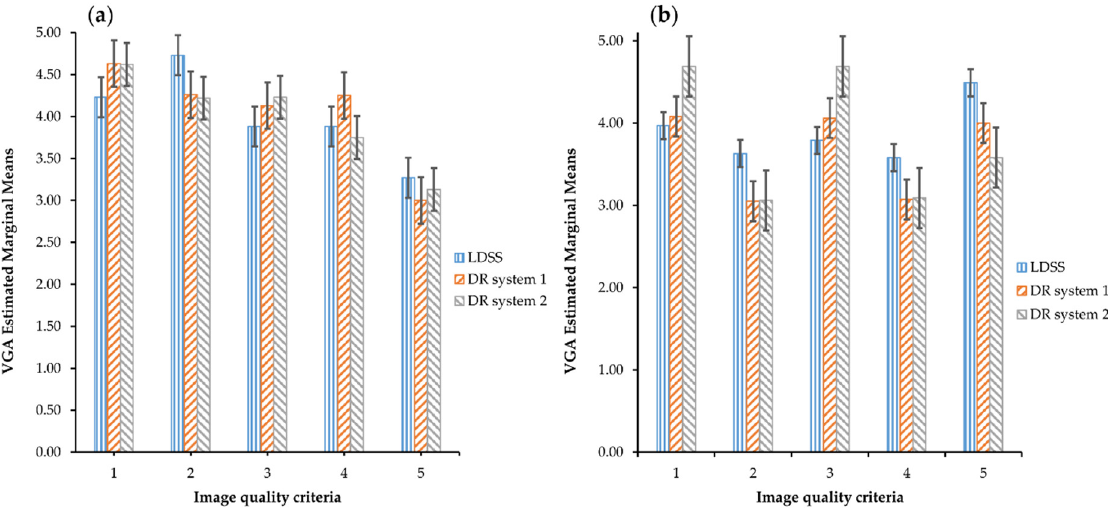
Figure 3. VGA estimated marginal mean comparison across the imaging systems and image quality criteria, ( a ) for the knee